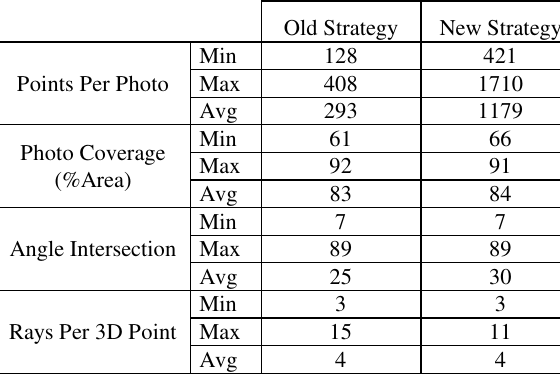
Table 3. Comparison summary of the Marbrees sequence.